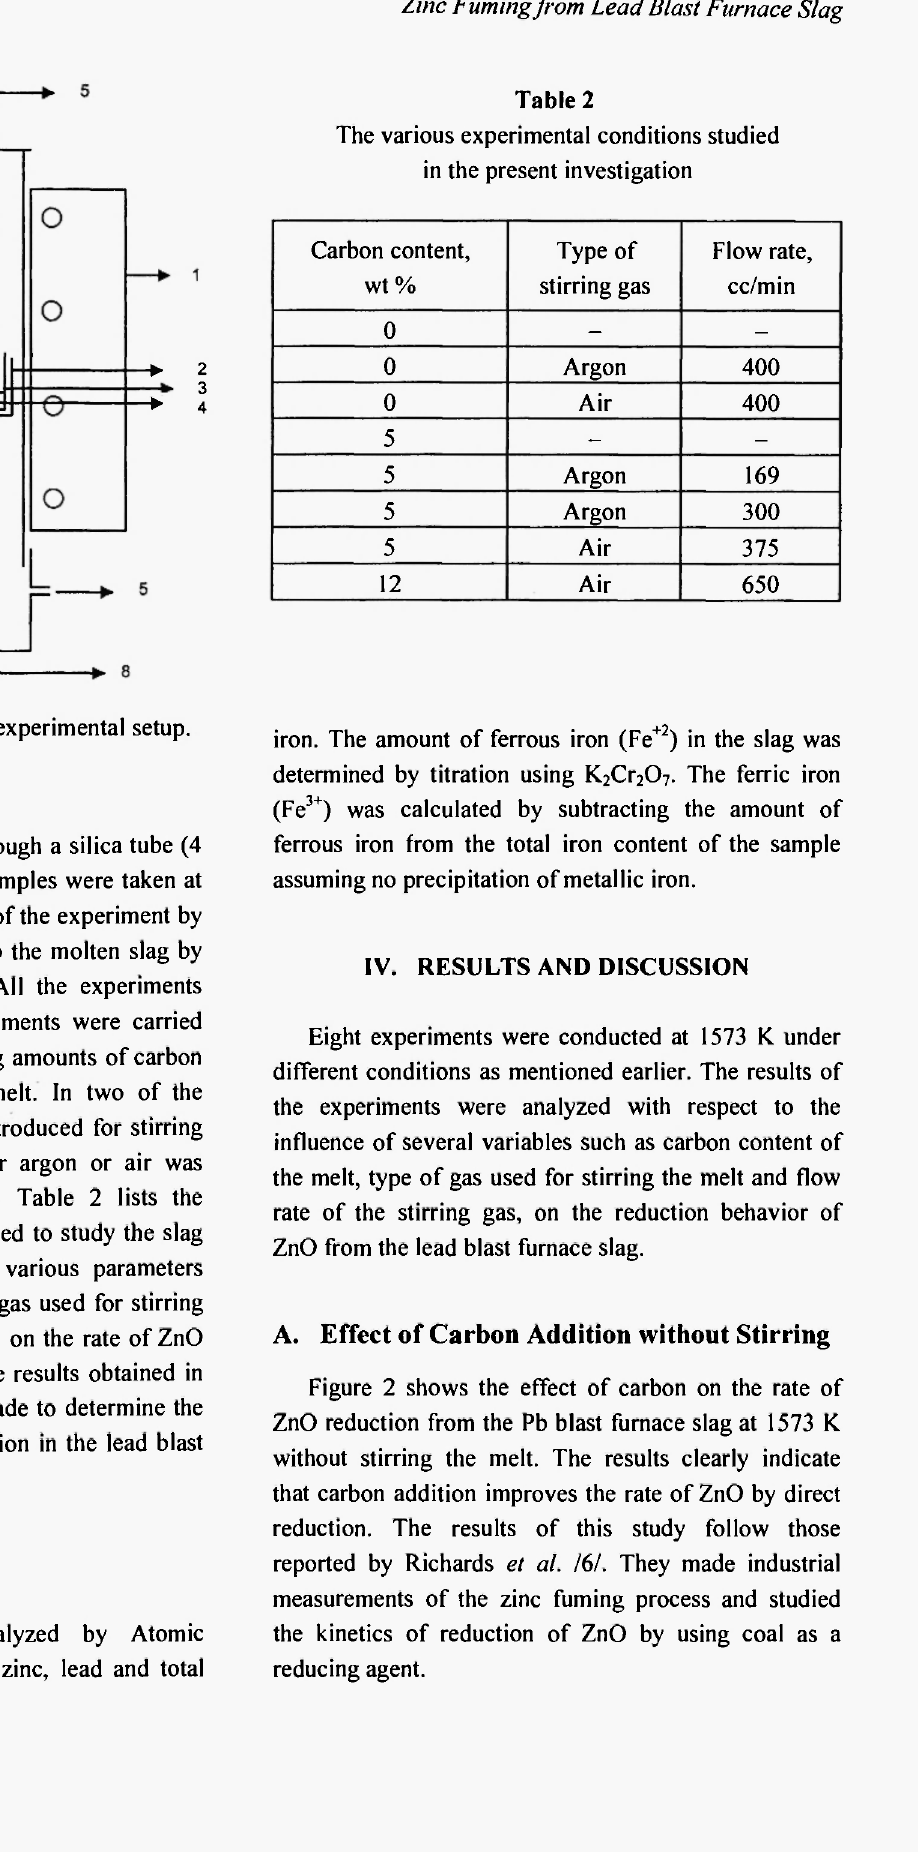
Fig. 1 : Schematic diagram of the experimental setup.